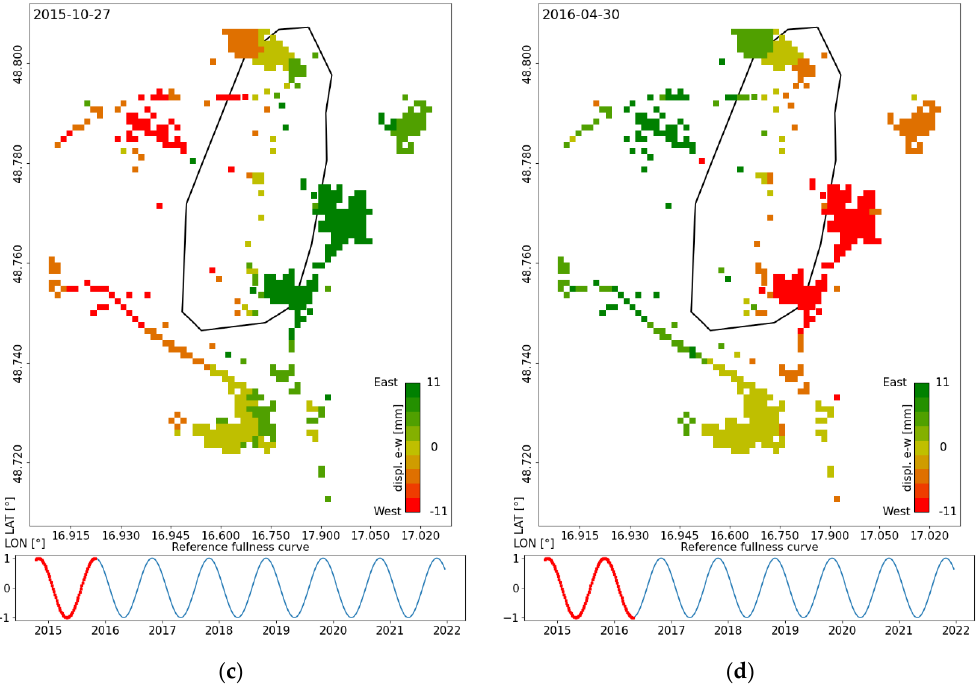
Figure 16. Distribution of U – D ( a , b ) and E – W ( c , d ) motions in the Tvrdonice UGS area after spatial smoothing was applied on individual patches. In the case of horizontal motion, positive values mean a shift to the east, the negative values mean a shift to the west.